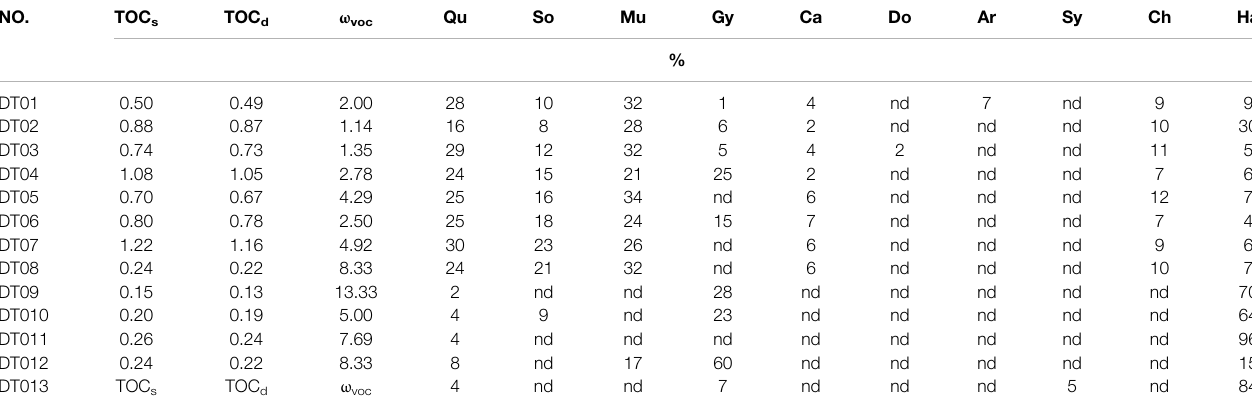
TABLE 1 | Total organic carbon, volatile organic compounds ratio, and mineral composition in the samples.